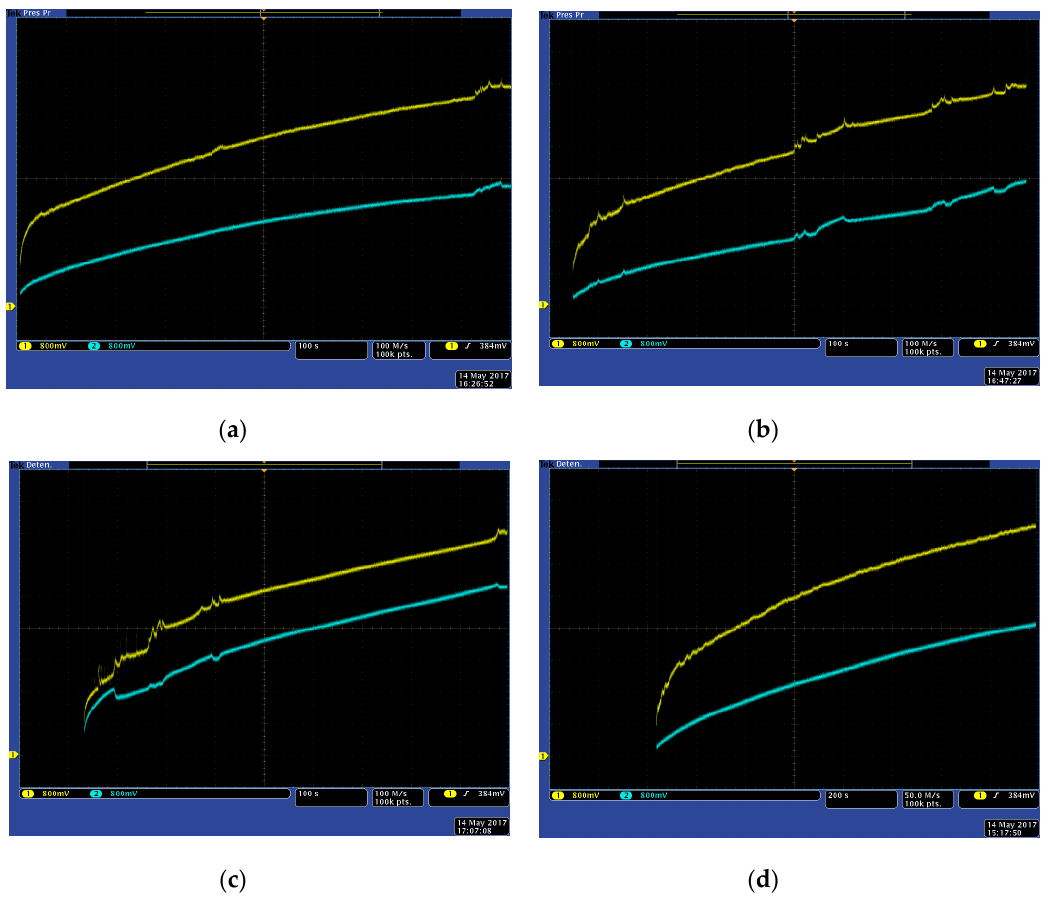
Figure 17. Charge curves for a 1.5 F supercap for a VOC algorithm using a reference panel (blue) and the ANN-based solar panel model (yellow). Environmental conditions (irradiance and temperature, average): ( a ) 850 W/m 2 , 35 °C; ( b ) 1300 W/ m 2 , 55 °C; ( c ) 1120 W/ m 2 , 43 °C; ( d ) 500 W/ m 2 , 26 °C.